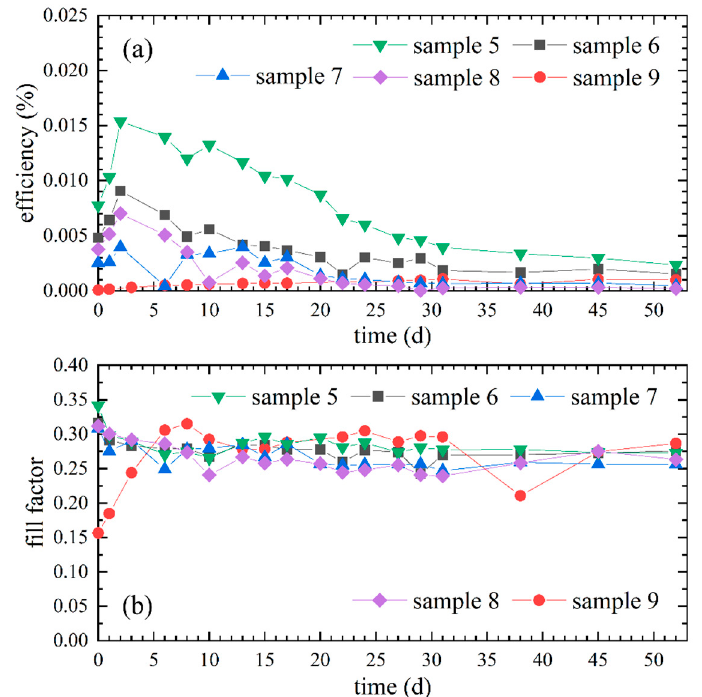
Figure 5. Influence of gel electrolyte drying before DSSC assembly on the progression of photovoltaic performance: ( a ) Efficiencies of sample 5 with a not dried gel electrolyte, sample 6, 7 and 8 with at room temperature dried gel electrolytes for 0.5 h, 1 h and 2 h, respectively, and sample 9 with a gel electrolyte dried in the oven; ( b ) Corresponding fill factors of these DSSCs with differently dried gel electrolytes.